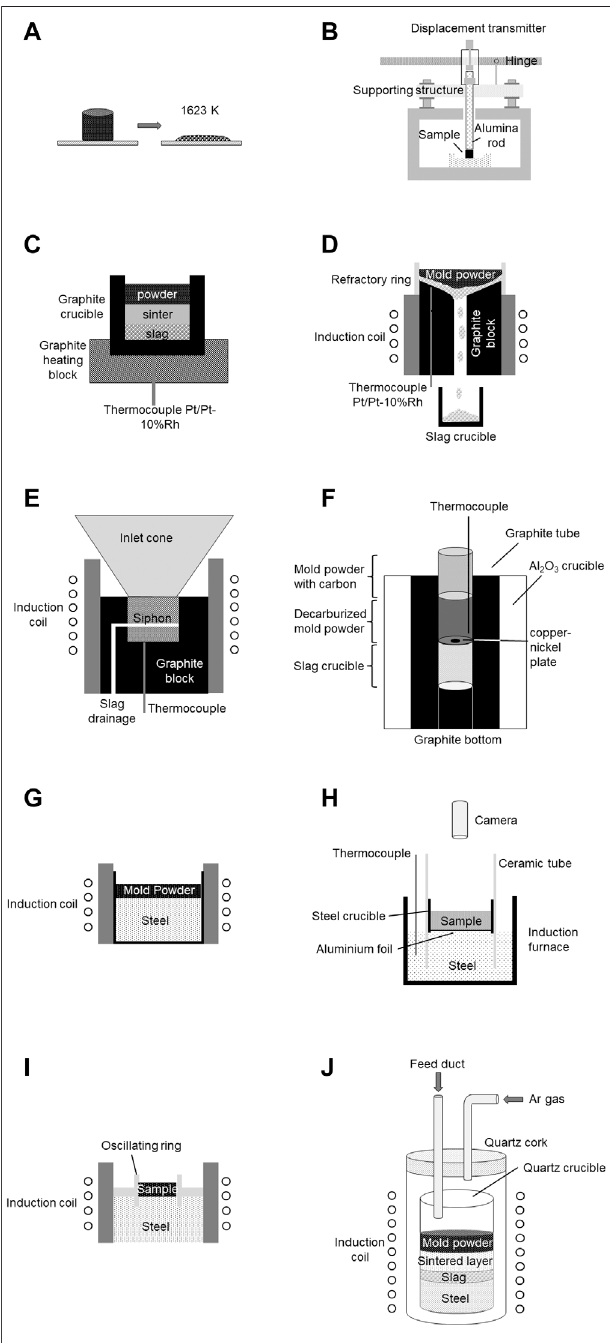
FIGURE1| Schematicdrawingsoflaboratorymethods, wherethemold powder is applied on a preheated surface according to (Hou et al., 2006), (Kromhout and van der Plas, 2002), (Koyama et al., 1987), (Xie et al., 1991), (Däcker et al., 2009), (Münch, 2019), (Takeuchi et al., 1979), (Kromhout and van der Plas, 2002), (Nakano et al., 1987), and (Kamaraj et al., 2020): (A) melting point tester (M6), (B) softening method (M7), (C) setup for the measurement of the melting rate under unidirectional heating (M8), (D) setup for the measurement of the melting rate under unidirectional heating under slag drainage (M9), (E) laboratory melting method (M10), (F) method for the simulation of mold powder layers (M11), (G) setup for the measurement of